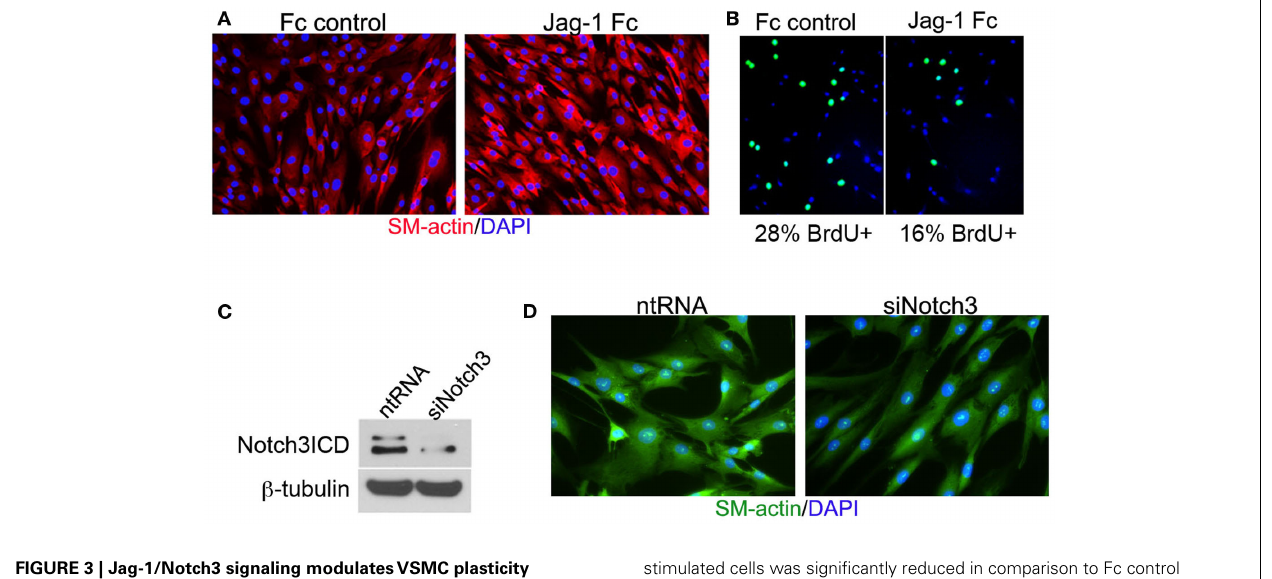
FIGURE 3 | Jag-1/Notch3 signaling modulatesVSMC plasticity toward maturation and contraction. Human aorticVSMC were plated on immobilized recombinant rat Jag-1 Fc or Fc control for 48h to activate Notch receptors. Immunostaining reveals a significant increase in the expression of the contractile protein SM-actin in response to active Notch signaling (A) . BrdU incorporation into the nuclei of Jag-1 Fc